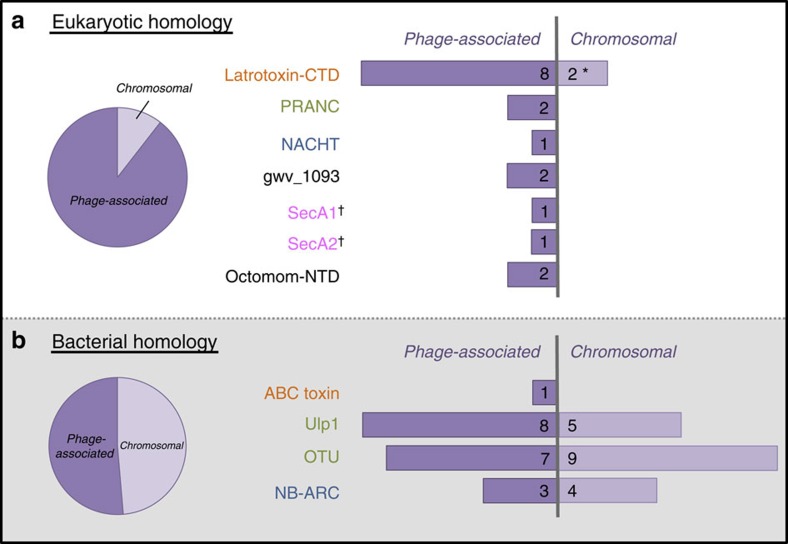
Eukaryotic-like EAM genes are enriched in prophage WO regions.EAM genes with (a) eukaryotic homology are most likely to be associated with prophage WO while those with (b) bacterial homology are both phage-associated and found scattered throughout the Wolbachia chromosome. *The two chromosomal latrotoxin-CTD domains (wNo_10650 and wHa_05390) are located within phage-associated genes and transposases, indicating a potential genomic rearrangement. †SecA represents one ‘domain type' but is listed separately because phage WO contains two different homologues (that is, wHa_3920 and wHa_3930). Putative functional categories are as follows: anti-eukaryotic toxins (orange); host–microbe interactions (green); host cell suicide (blue); secretion of virulence factors (pink); and unknown (black). Octomom refers to WD0513 of the wMel genome.